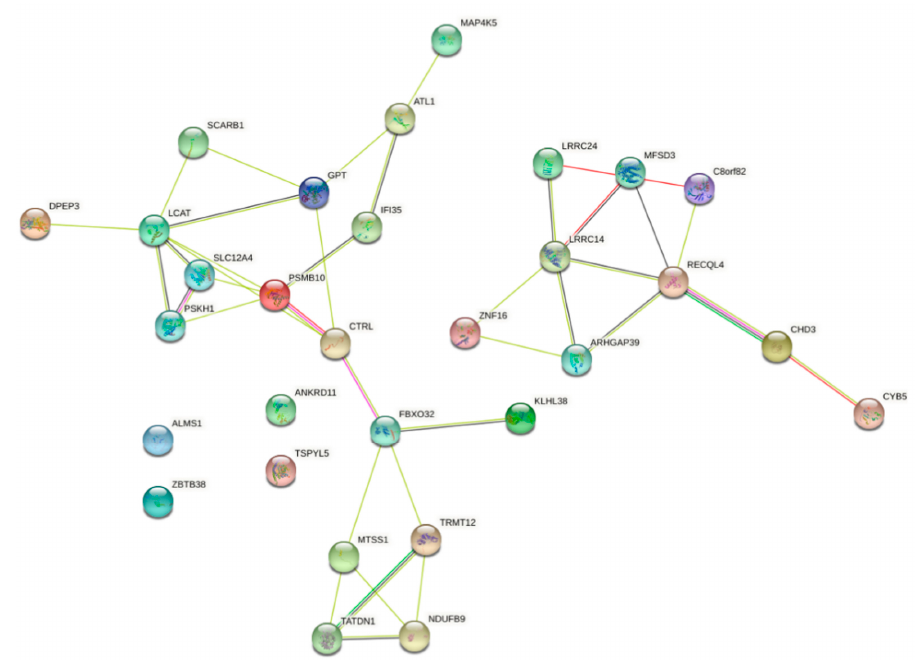
Figure 8. Enriched proteins in the KEGG pathway for cancer.